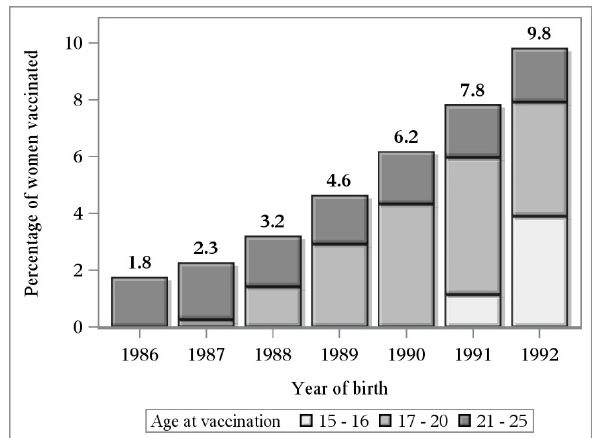
Figure 1. Percentage of vaccinated women according to year of birth, stratified by age at vaccina- tion.